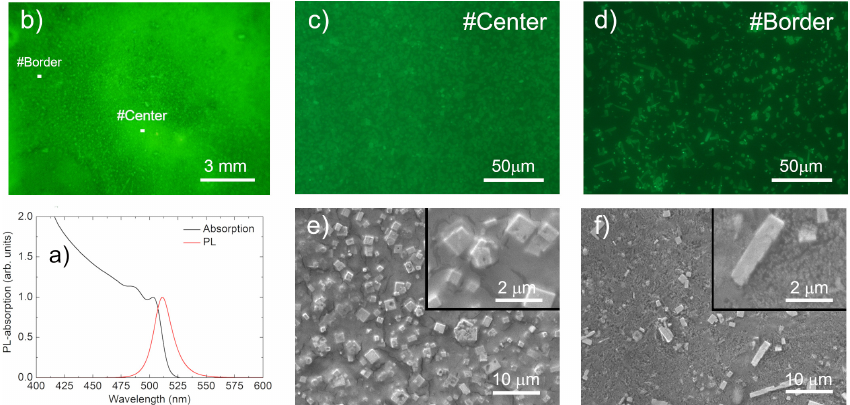
Figure 1. ( a ): Absorbance and PL spectra of the investigated NCs in solution. ( b ): Image of the sample from an optical microscope. The white rectangles show the typical morphologies of the regions in which the PL mapping was performed. ( c ): A 220 µ m × 160 µ m PL map at the #Center point. ( d ): A 220 µ m × 160 µ m PL map at the #Border point. ( e ): SEM image at the #Center point with 2000 × and (inset) 6000 × magnification. ( f ): e: SEM image at the #Border point with 2000 × and (inset) 6000 ×